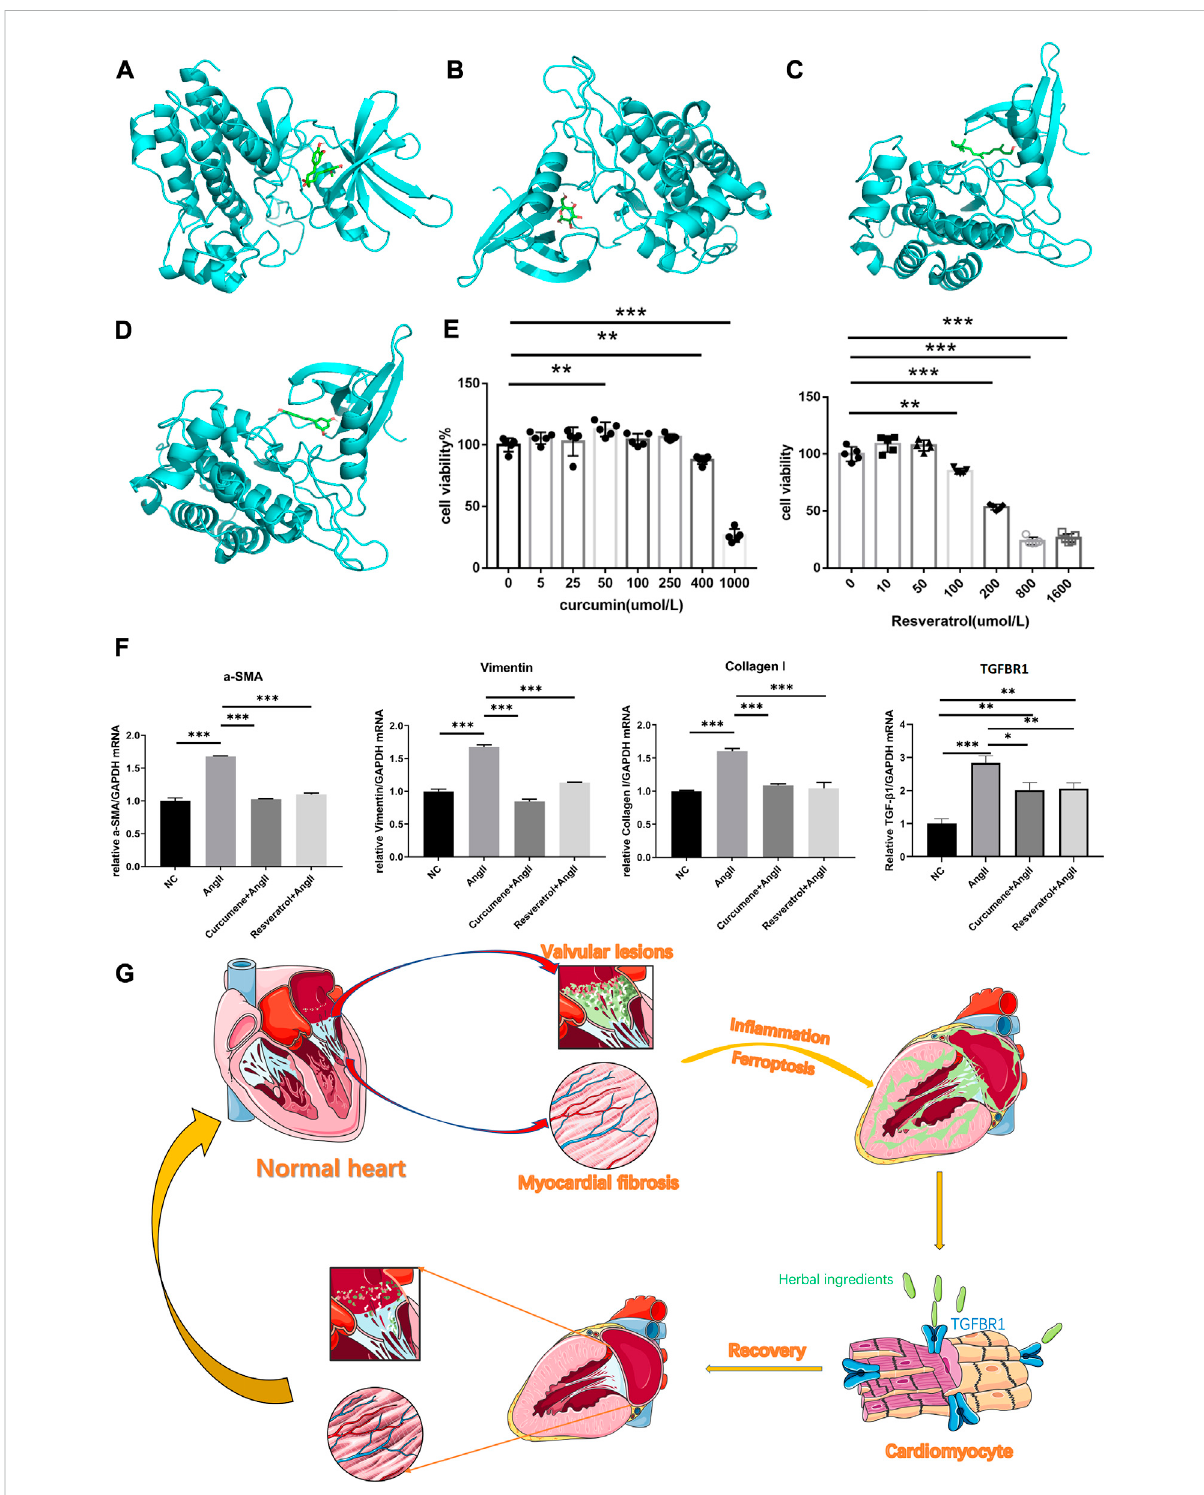
FIGURE 4 (A) The best binding model of curcumin to TGFBR1 with a minimum binding free energy of 8.6 kcal/mol. (B) The best binding model of D-glucose to TGFBR1 with a minimum binding free energy of 5.7 kcal/mol. (C) The best binding model of oleovitamin A to TGFBR1 with a minimum binding free energy of 7.2 kcal/mol. (D) The best binding model of resveratrol to TGFBR1 with a minimum binding free energy of 8.5 kcal/mol (E) CCK-8 assays was used to measure the viability of HL-1 cells. (F) Quantitative reverse transcription-PCR was used to measure the key gene expression levels. Data are shown as mean ± standard error of the mean. * p < 0.05, ** p < 0.01, *** p < 0.001. (G) The potential underlying mechanism